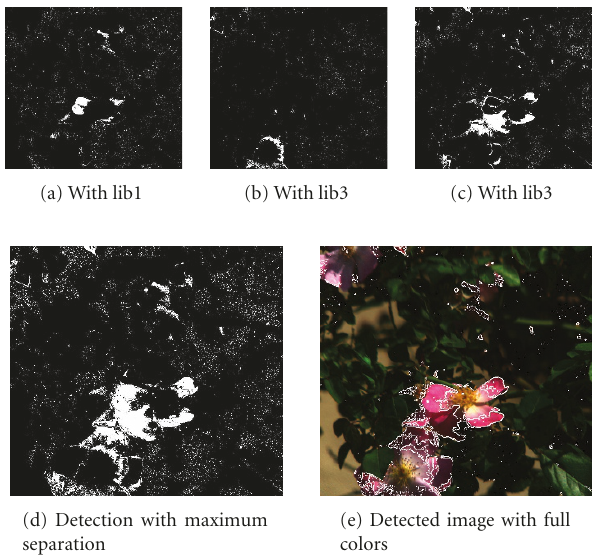
Figure 10: Result of detected image when maximum separation bands are used in the detection. Bands used are (2, 10, 18, 26).